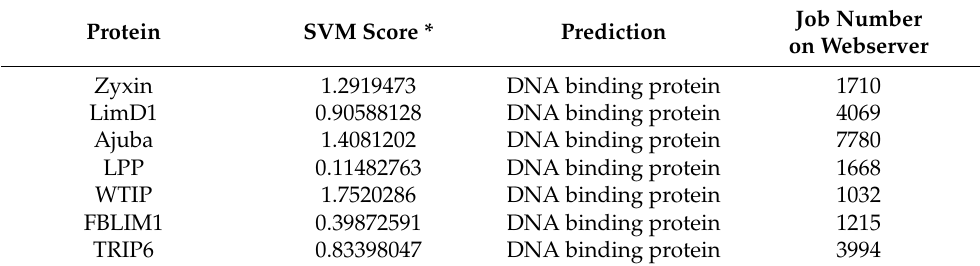
Table 4. SVM based prediction of DNA binding of Zyxin family proteins as calculated by DNAbinder